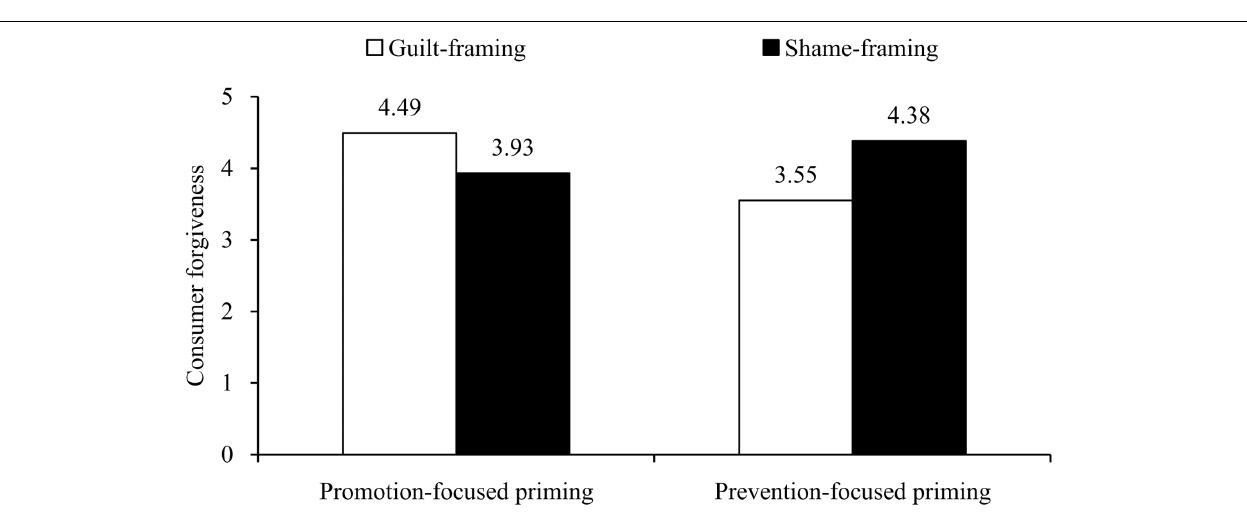
FIGURE 6 | Interaction effect of emotion and regulatory focus on forgiveness in the fear condition (Study